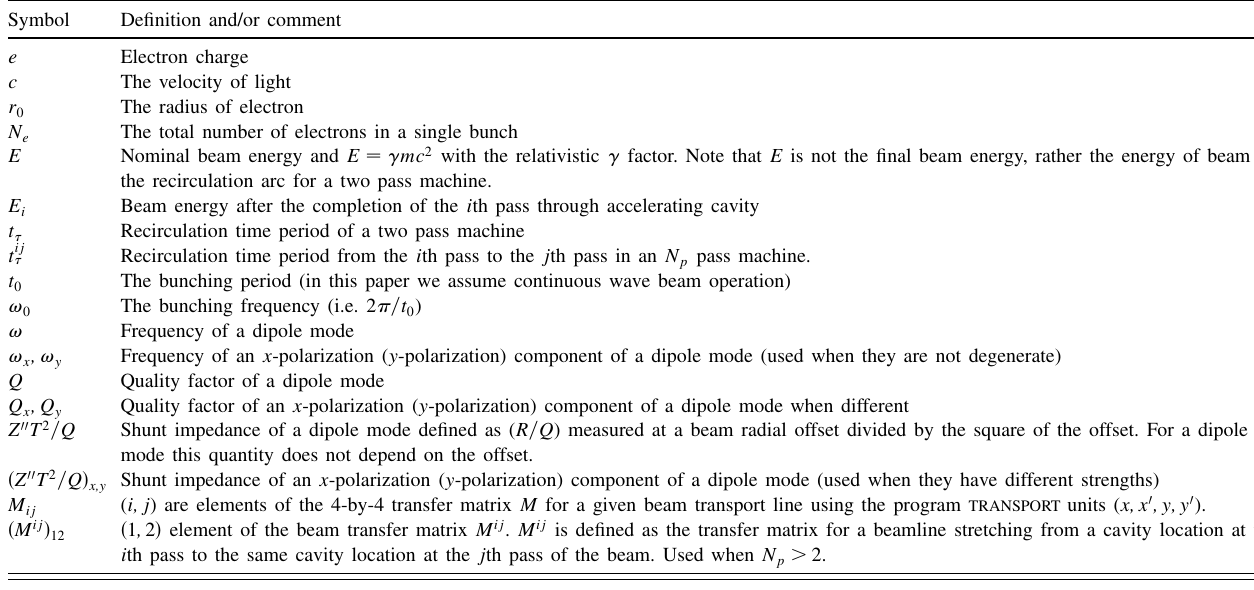
TABLE I. Summary of